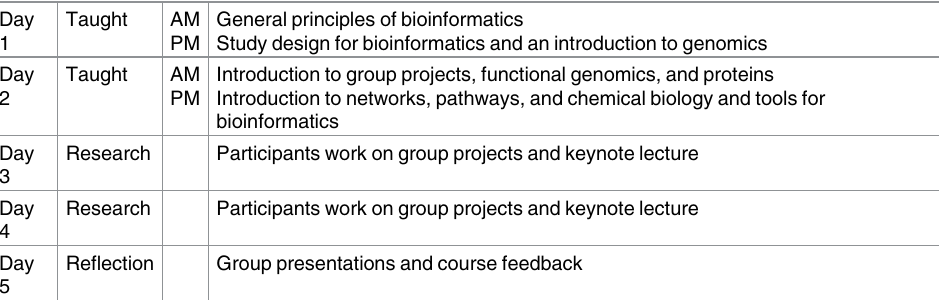
Table 1. Overview of programme